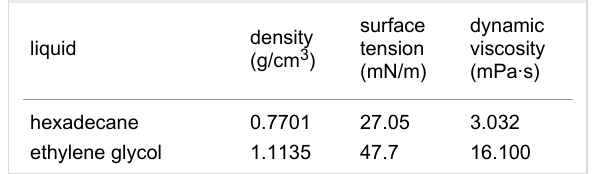
Table 2: Properties of the liquids used in the experiments [30].